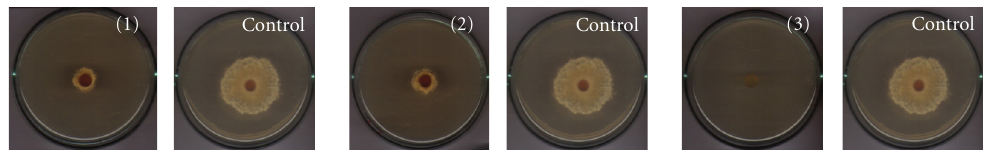
Figure 4: Images of the symbiotic fungus in the presence of the lignans (+)-sesamin ( 1 ), ( − )-hinokinin ( 2 ), and ( − )-kusunokinin ( 3 ) after 30 days of inoculations and the respective